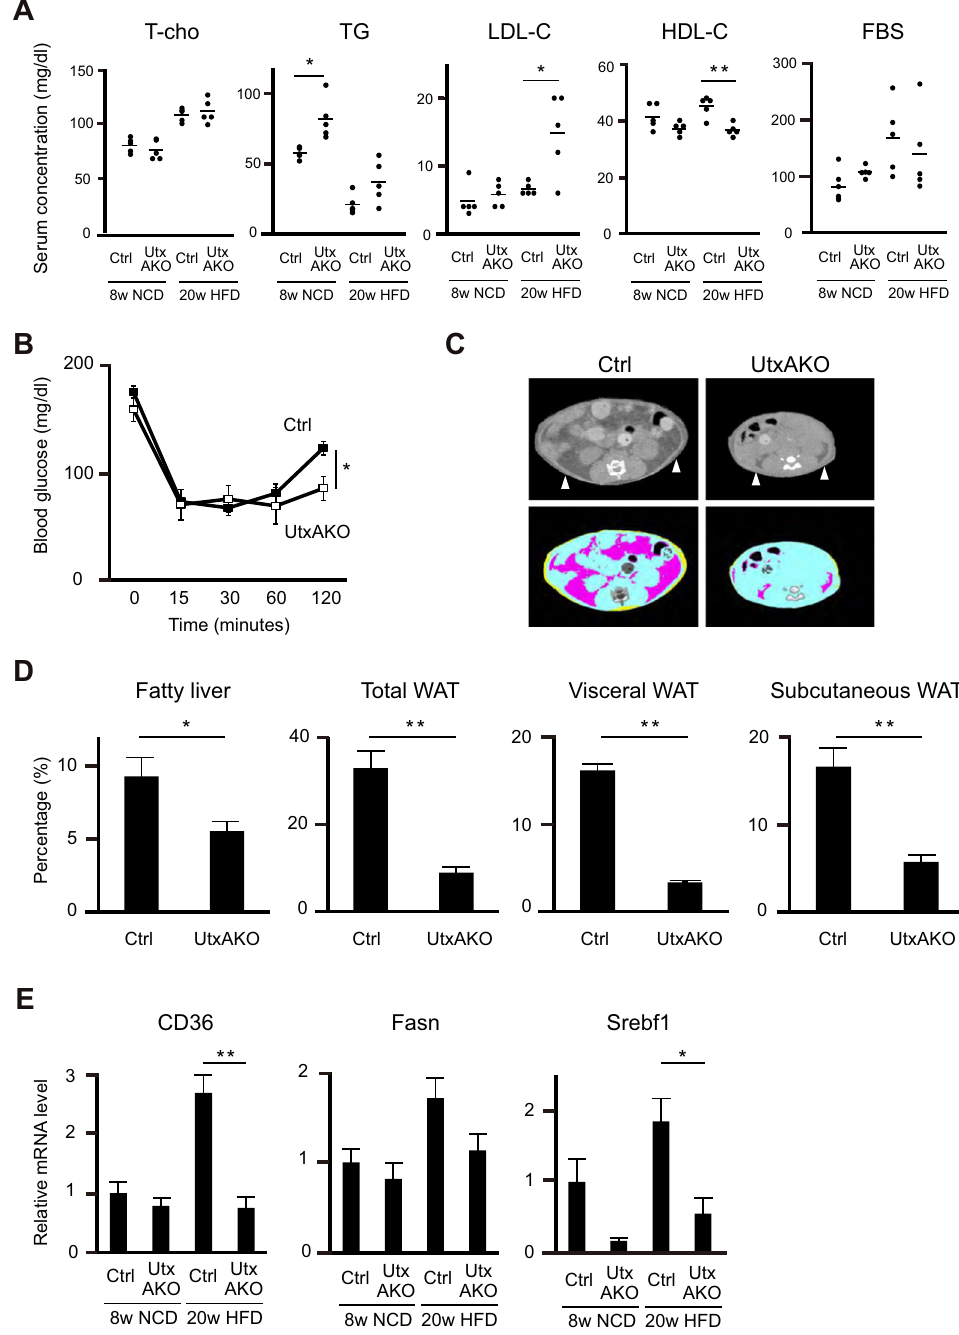
Figure 2. Metabolic profiling of female UtxAKO mice on HFD. ( A ) Quantitation of serum levels of the indicated metabolites in f-NCD-Ctrl and f-NCD-UtxAKO mice at 8 weeks of age, and in f-HFD-Ctrl and f-HFD-UtxAKO mice at 20 weeks of age ( n = 5/group). T-cho, total cholesterol; TG, triacylglycerol; LDL-C, LDL cholesterol; HDL-C, HDL cholesterol; FBS, fasting blood glucose after 16 hr starvation. ( B ) Time course of blood glucose levels in f-HFD-Ctrl and f-HFD-UtxAKO mice ( n = 5/group) that were fasted for 3 hr and received i.p. injection of insulin (0.75 mIU/g BW). Plasma glucose levels were measured at the indicated time points. ( C ) Representative CT images of abdomens of f-HFD-Ctrl and f-HFD-UtxAKO mice at 20 weeks ( n = 7/group). CT images at the same sectional levels were compared. Upper panels: Arrowheads indicate low density areas corresponding to fat. Lower panels: Pink and yellow areas indicate visceral and subcutaneous fats, respectively. ( D ) Quantitation of hepatic steatosis (fatty liver) and percentage of total WAT, visceral WAT and subcutaneous WAT in f-HFD-Ctrl and f-HFD-UtxAKO mice at 20 weeks ( n = 7/group). ( E ) Quantitative RT-PCR determination of mRNA levels of the indicated genes in livers of f-NCD-Ctrl and f-NCD-UtxAKO mice at 8 weeks, and f-HFD-Ctrl and f-HFD-UtxAKO mice at 20 weeks ( n = 5/group). Results are expressed relative to the mRNA level of TBP (internal